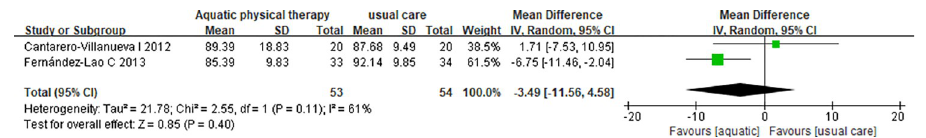
Fig 5. Meta-analysis of studies assessing waist circumference between aquatic physical therapy and usual care.